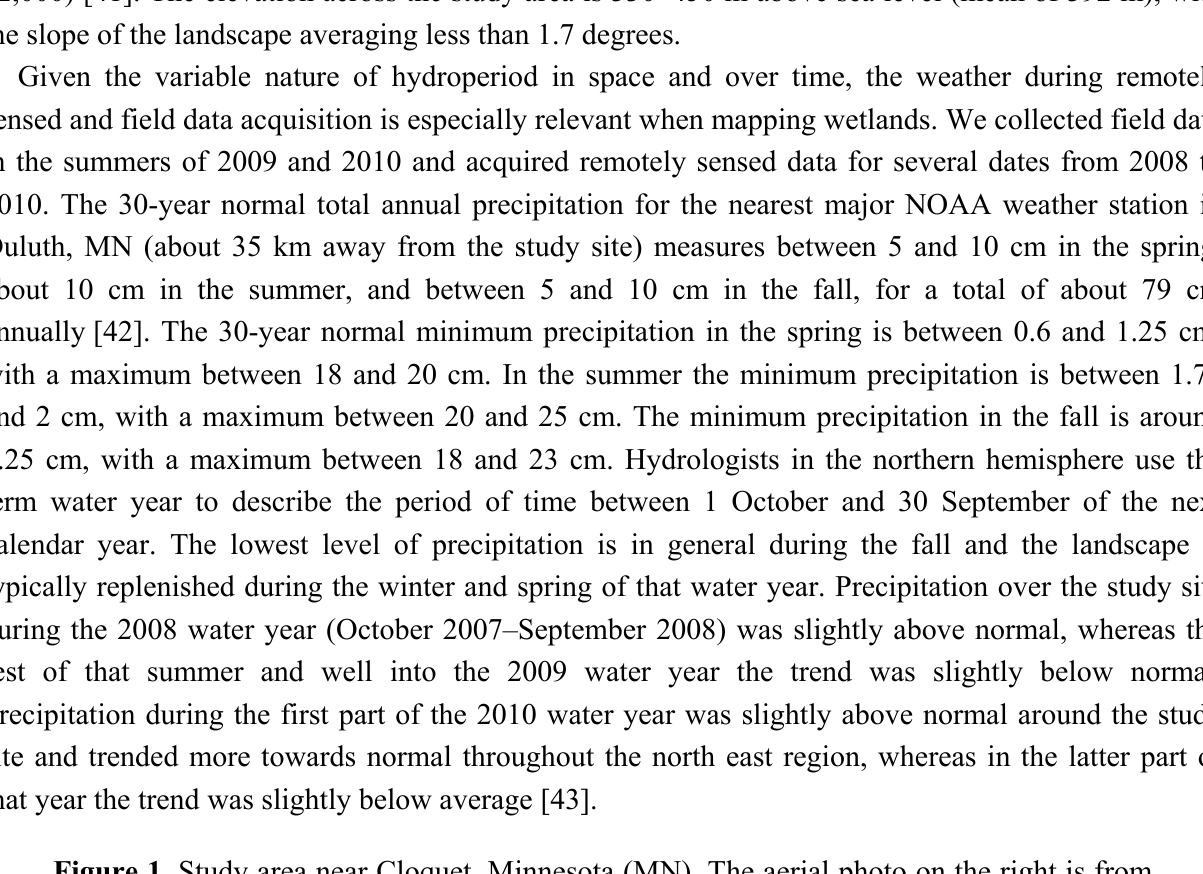
Figure 1. Study area near Cloquet, Minnesota (MN). The aerial photo on the right is from the 2008 National Agricultural Imagery Program